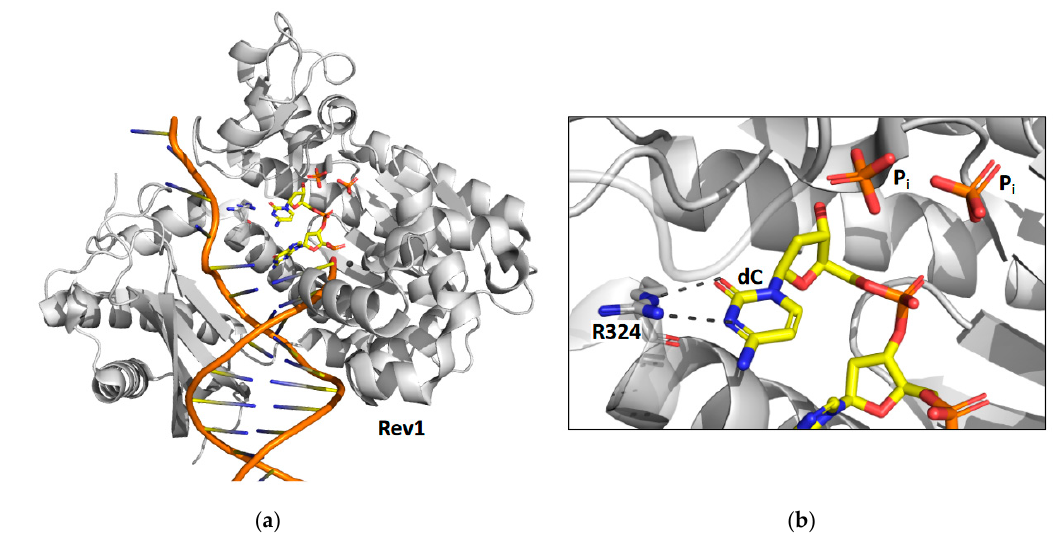
Figure 2. Time-lapse X-ray crystallography of the Rev1 catalytic core. Shown are the overall structure of the Rev1 product complex bound to DNA ( a ) and a close-up of the active site with the positions of the two inorganic phosphate products (P i ) and a key amino acid residue (R324) highlighted ( b ). For the products, carbon atoms are shown in yellow, nitrogen atoms are shown in blue, oxygen atoms are shown in red, and phosphorus atoms are shown in orange. This figure was generated with 6X72.pdb